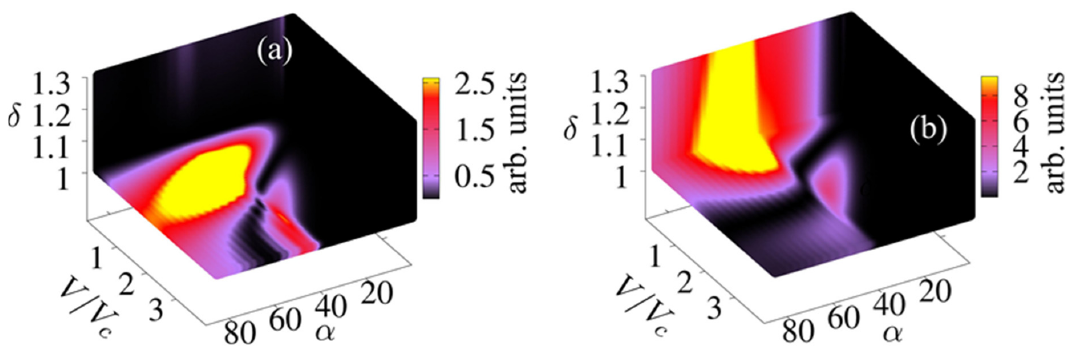
Figure 4. ( a ) Third harmonic ( a ) second and ( b ) third harmonics output powers (arb. units) in a superlattice with period d , as a function of α = ( eE i ) d / ( h ν ) , V (voltage) and δ (asymmetry parameter). This parameter is directly proportional to the input electromagnetic field oscillating at ν = 249 GHz. The control voltage, V / V c is given as a ratio with respect to the critical voltage V c , which characterizes negative differential resistance U c = eV c . The idea is to focus on the voltage, field and asymmetry control.